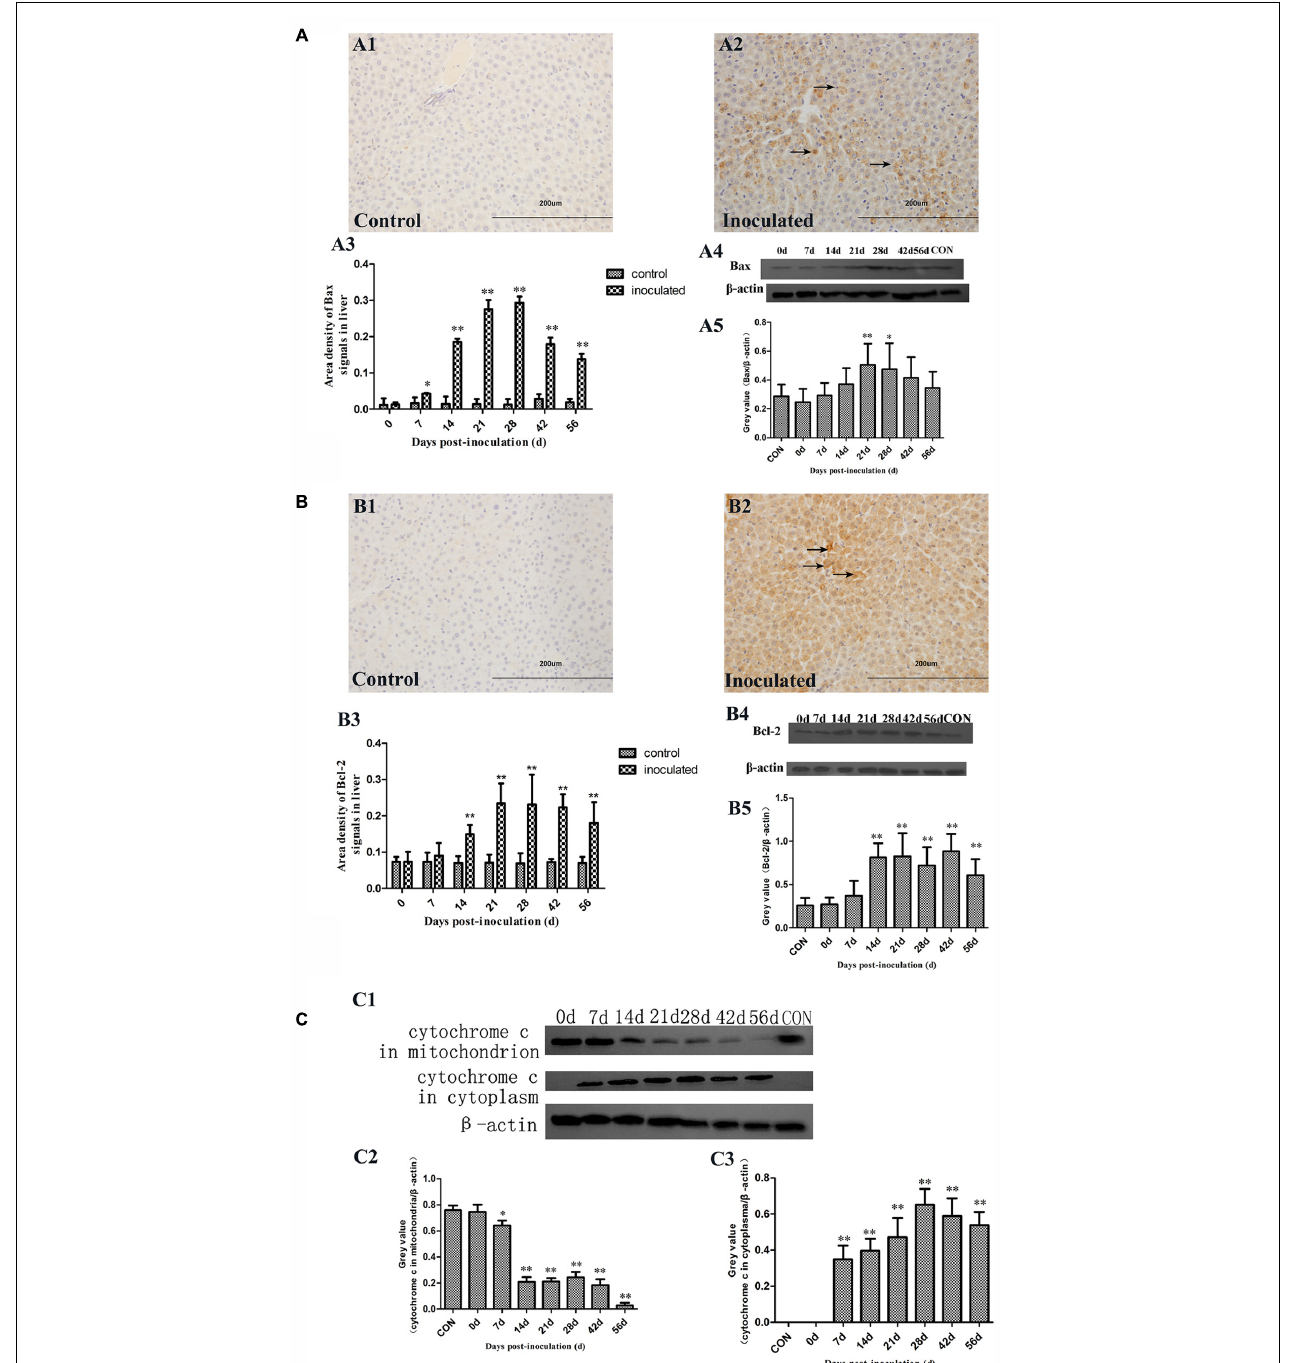
FIGURE 5 | Immunohistochemical and western-blot analysis of Bax, Bcl-2, and cytochrome c proteins. (A1) IHC analysis of livers in control group, (A2) IHC analysis of livers in inoculated group. The primary antibody was Bax antibody, and positive signals were observed in the cytoplasm of hepatocyte ( → ); (A3) A semi-quantitative analysis of the ratio of Bax positive staining to the total field; (A4) Western-blot analysis of Bax in hepatocyte of control group and inoculated group gerbils; (A5) A semi-quantitative analysis of relative expression of Bax/ β -actin. (B1) IHC analysis of livers in control group, (B2) IHC analysis of livers in inoculated group. The primary antibody was Bcl-2 antibody, and the positive signals were observed in the cytoplasm of hepatocyte ( → ); (B3) A semi-quantitative analysis of the ratio of Bcl-2 positive staining to the total field; (B4) Western-blot analysis of Bcl-2 in hepatocyte of control group and inoculated group gerbils; (B5) A semi-quantitative analysis of relative expression of Bcl-2/ β -actin. (C1) Western-blot analysis of cytochrome c in mitochondrion and cytoplasm of hepatocyte of control group and inoculated group gerbils. (C2) A semi-quantitative analysis of relative expression of cytochrome c in mitochondria/ β -actin. (C3) A semi-quantitative analysis of relative expression of cytochrome c in cytoplasm/ β -actin. ∗ p < 0.05, ∗∗ p < 0.01.